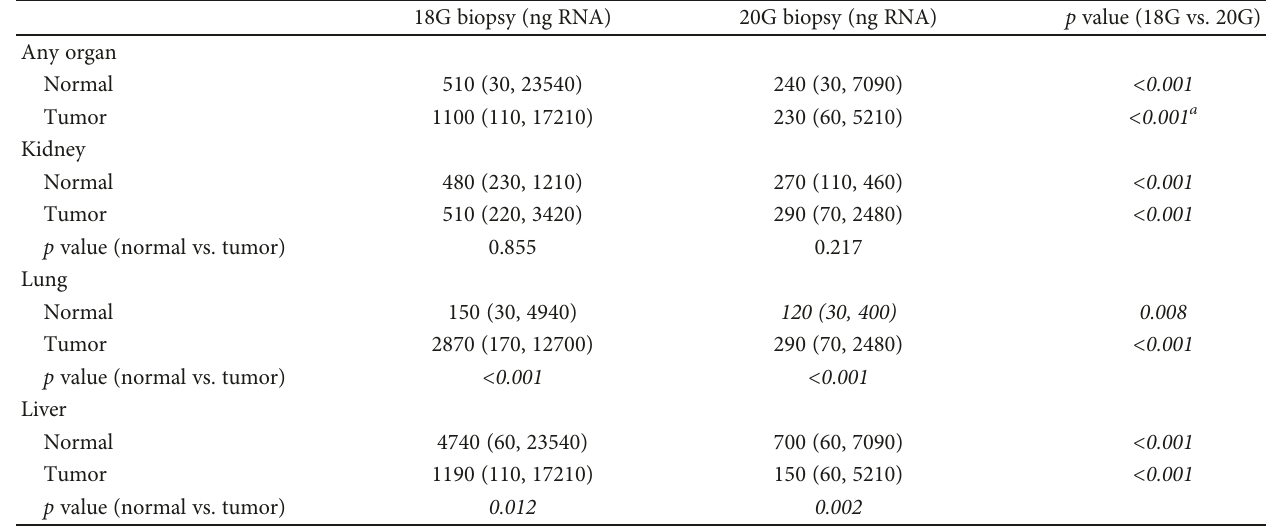
Table 3: Median RNA (range) from 18- versus 20-gauge needle samples from normal and tumor tissues obtained from the kidney, lung, and